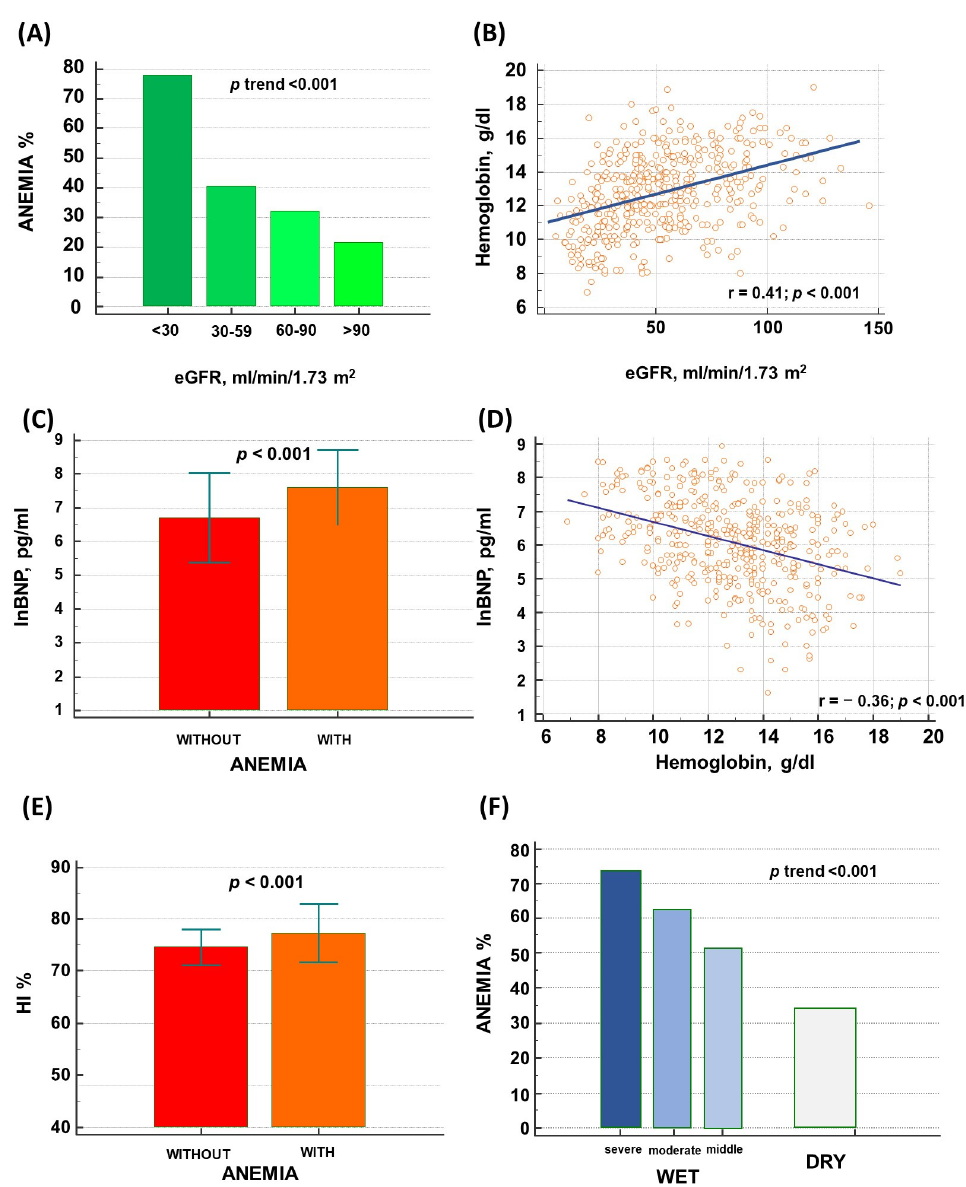
Figure 2. ( A ) Relationship between anaemia and renal function, the latter categorised into four groups according to the values of the estimated glomerular filtration rate. ( B ) Relationship between renal function—considered as a continuous variable—and hemoglobin levels. Comparison of BNP concentration between patients with and without anaemia ( C ), and correlation between BNP and hemoglobin levels ( D ). Comparison of hydration status between patients with and without anaemia ( E ), and correlation between hydration status and hemoglobin levels ( F ).